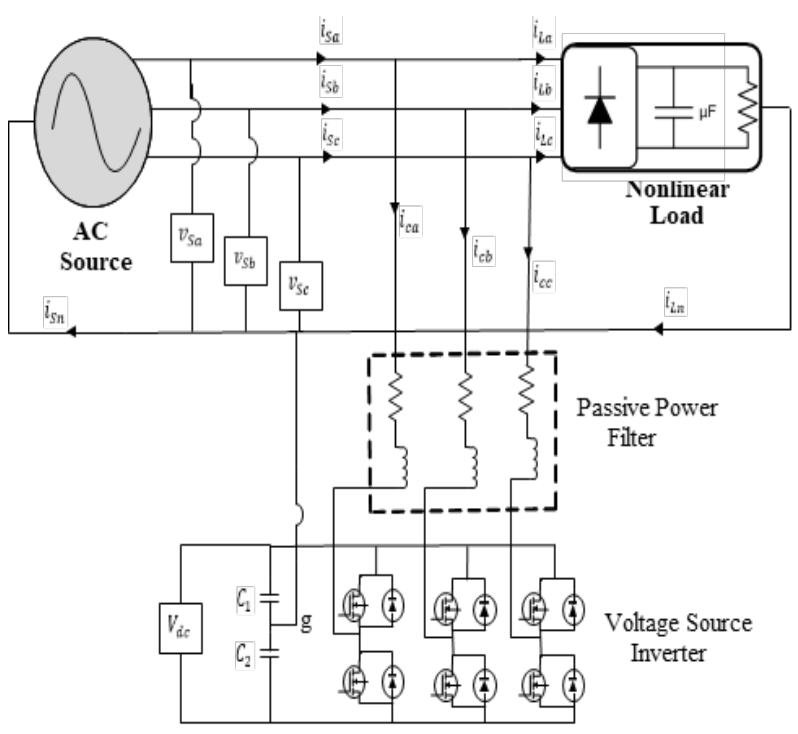
Figure 4. Three Phase H-Bridge Shunt APF Topology.